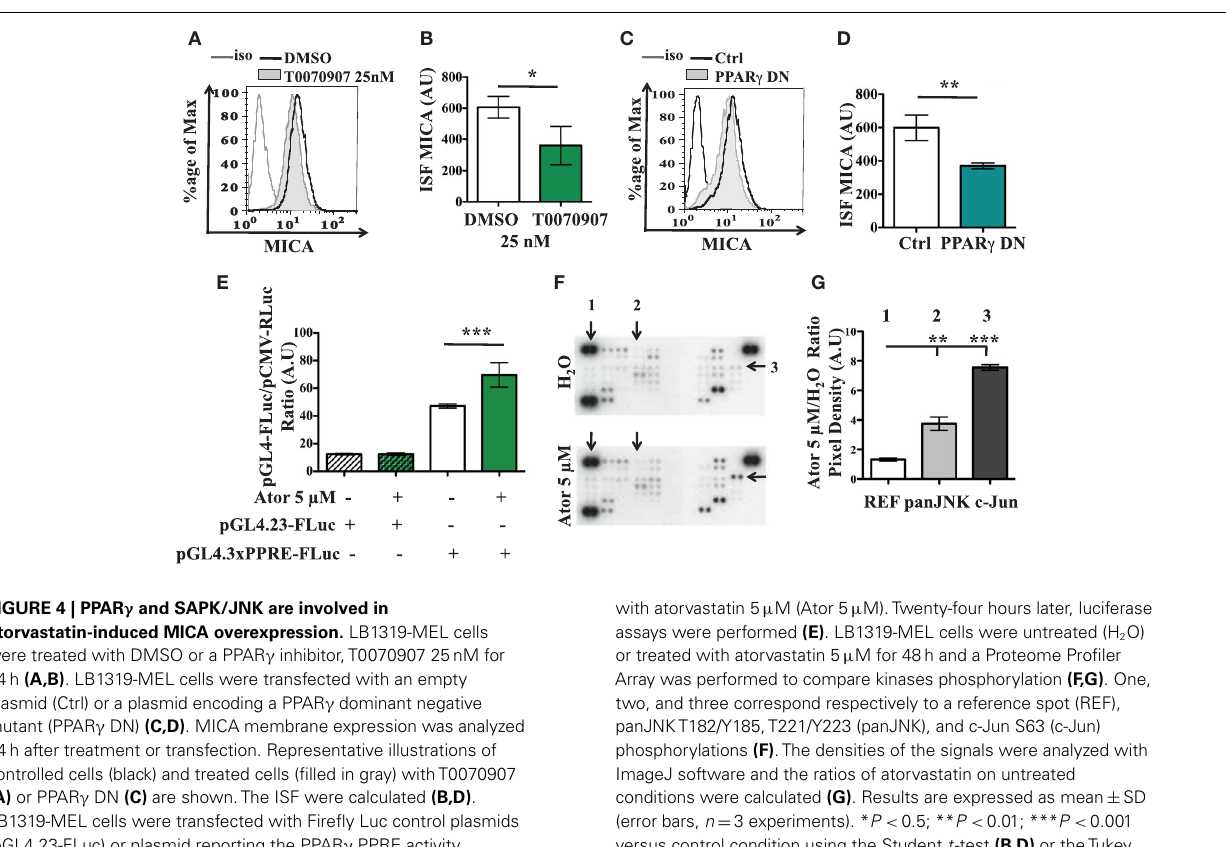
FIGURE 4 | PPAR γ and SAPK/JNK are involved in atorvastatin-induced MICA overexpression. LB1319-MEL cells were treated with DMSO or a PPAR γ inhibitor,T0070907 25nM for 24h (A,B) . LB1319-MEL cells were transfected with an empty plasmid (Ctrl) or a plasmid encoding a PPAR γ dominant negative mutant (PPAR γ DN) (C,D) . MICA membrane expression was analyzed 24h after treatment or transfection. Representative illustrations of controlled cells (black) and treated cells (filled in gray) withT0070907 (A) or PPAR γ DN (C) are shown.The ISF were calculated (B,D) . LB1319-MEL cells were transfected with Firefly Luc control plasmids (pGL4.23-FLuc) or plasmid reporting the PPAR γ PPRE activity (pGL4.3xPPRE-FLuc) and these cells were untreated (H 2 O) or treated